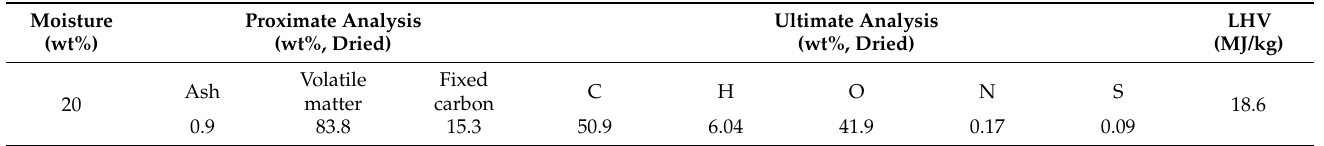
Table 1. Proximate and ultimate analysis of biomass feedstock.